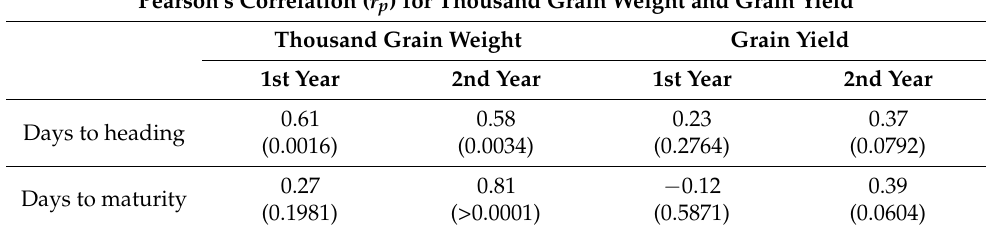
Table 3. Correlation co-efficient of heading and maturity time with thousand seed weight and seed